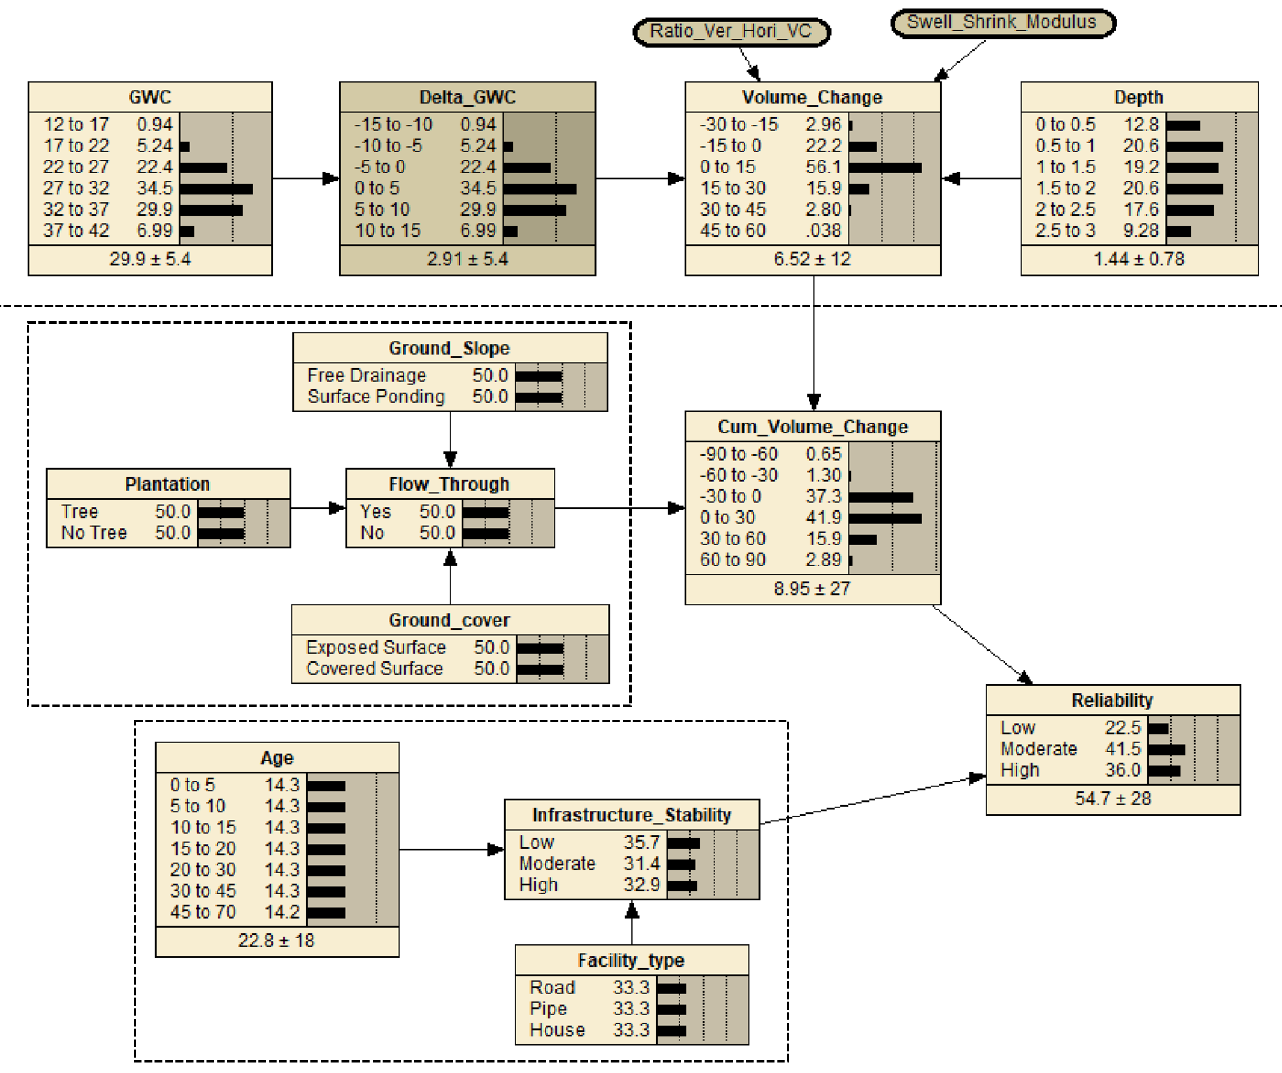
Figure 3. Proposed infrastructure reliability prediction model for expansive clays.